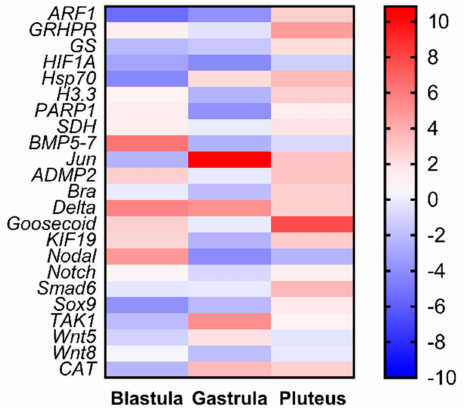
Figure 4. Heatmaps (Heatmapper available at www.heatmapper.ca) showing the expression profiles and hierarchical clustering of 23 genes analyzed by real-time qPCR in P. lividus embryos at the three di ff erent developmental stages (blastula, gastrula, and pluteus) treated with mixtures decadienal 0.3 µ M, heptadienal 0.7 µ M, and octadienal 1.0 µ M, and HEPEs 1.6 µ M. Colour code: red, up-regulated genes respect to the control (embryos grown without PUAs + HEPEs mixtures); blue, down-regulated